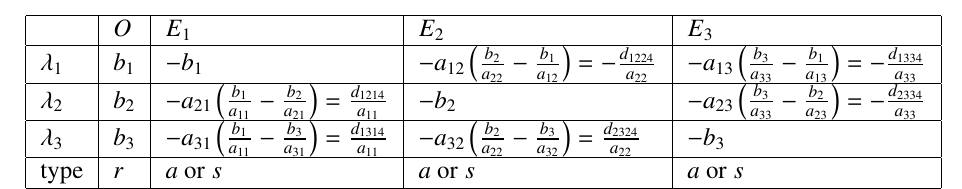
Table 2: The eigenvalues and types of first four equilibrium points of the system (13); the abbreviations a, r and s stand for attractor, repeller and saddle,